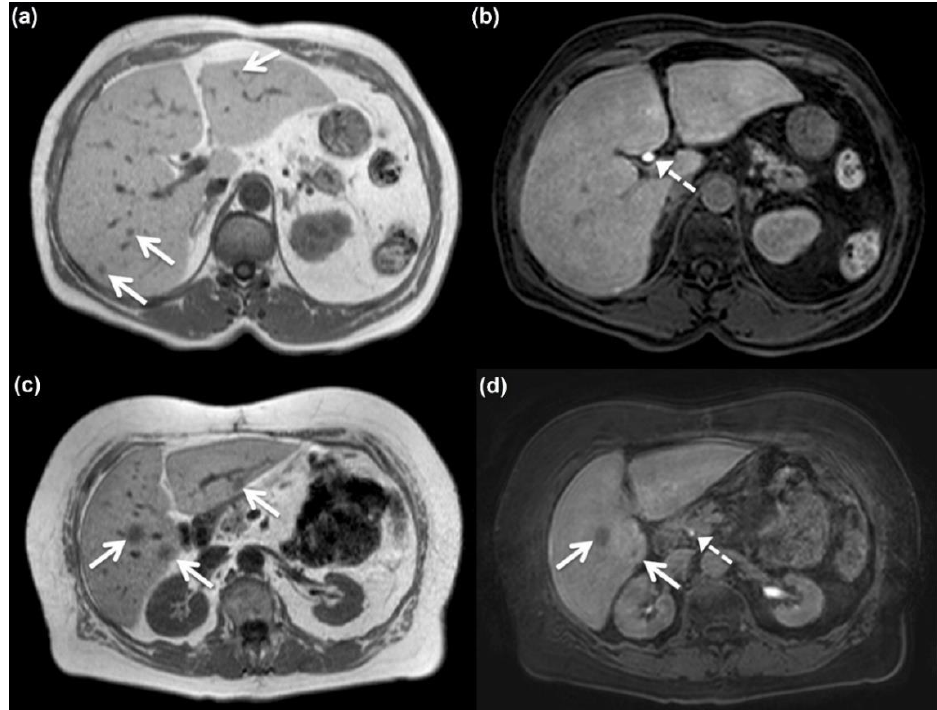
Figure 1. Patient 1 ( a , b ) and patient 2 ( c , d ), both with fatty liver and metastatic lesions (arrows) seen on unenhanced T1-weighted non-fat-saturated images ( a , c ) but only partially positive on the corresponding hepatobiliary phase images ( b , d ) acquired after gadoxetic acid administration. Note biliary excretion of the contrast agent (broken arrow).